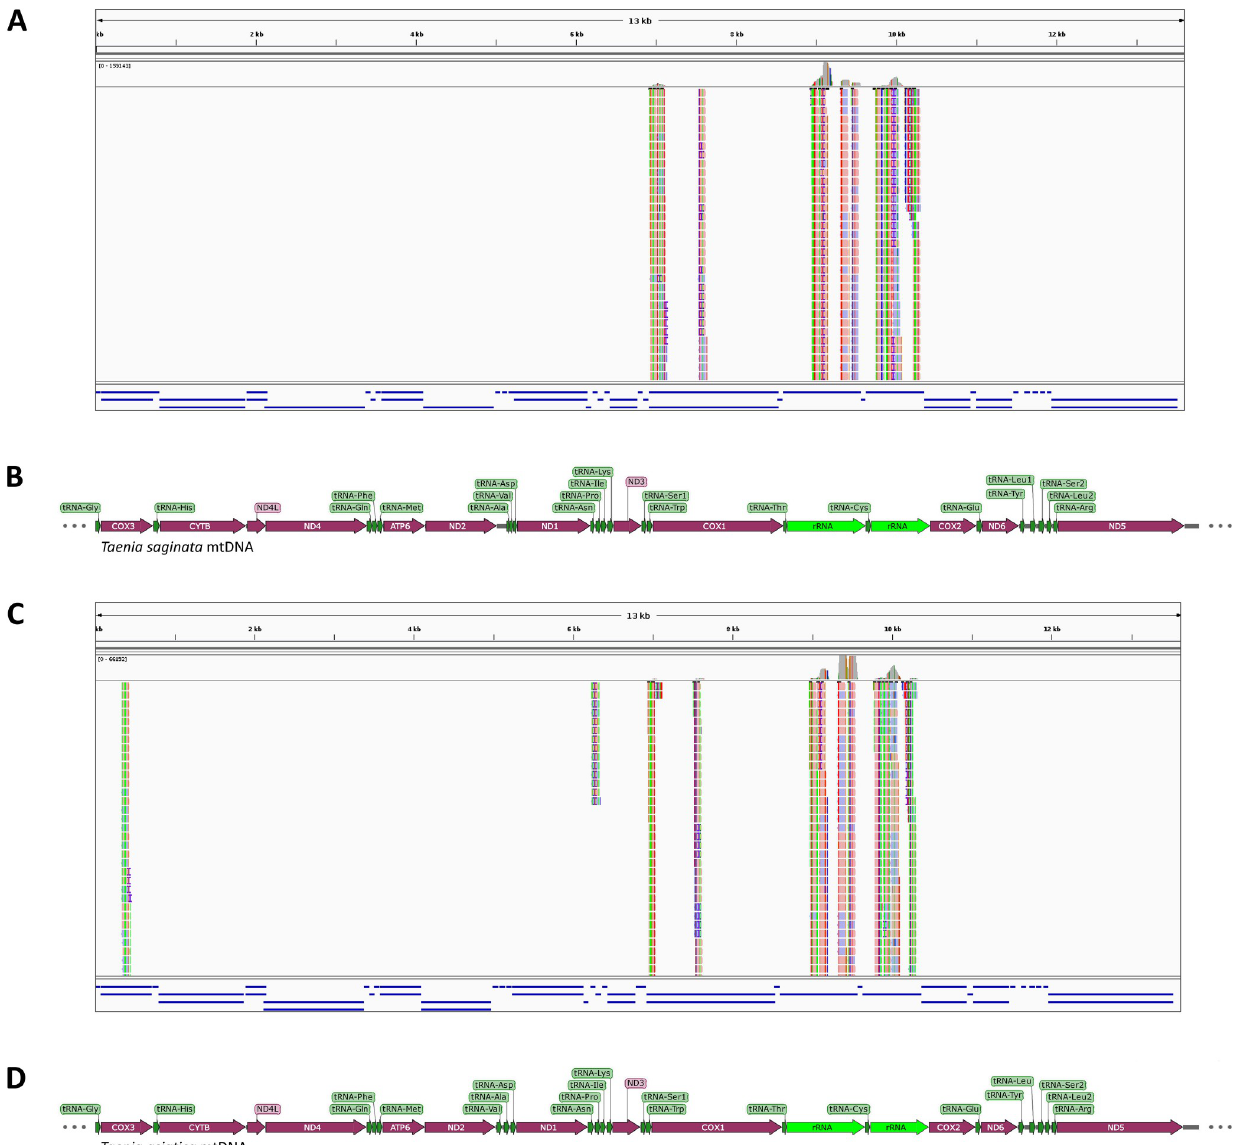
Fig 7. BWA MEM v0.7.12-alignment of the Taenia solium mitochondrial RNA to the mtDNA of other Taenia species. Alignment can only be found in areas of high conservation at the mtDNA genes encoding the subunit I of the cytochrome C oxidase (cox1) and the small and large mitochondrial rRNA fragments. ( A ) IGV visualization of the alignment to the T . saginata mtDNA, ( B ) annotation of the Taenia saginata mtDNA. ( C ) IGV visualization of the alignment to the Taenia asiatica mtDNA, ( D ) annotation of the Taenia asiatica